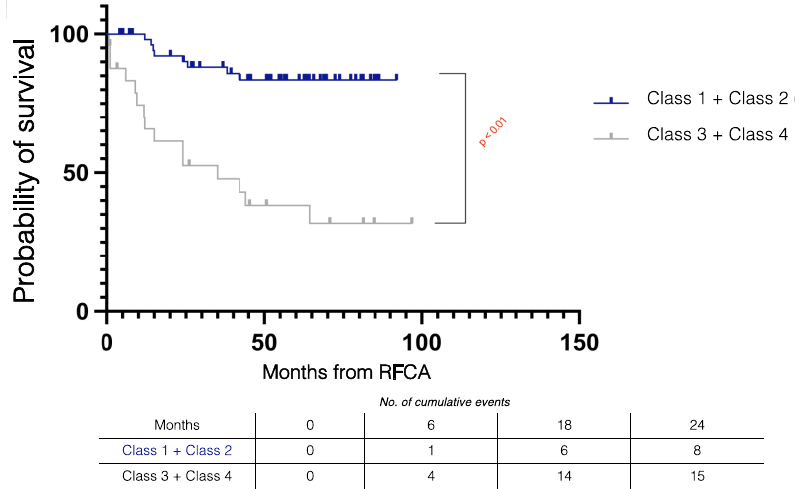
Figure 3. Kaplan–Meier survival curves stratified by combined procedural outcomes in electrical Figure 3. Kaplan – Meier survival curves stratified by combined procedural outcomes in electrical storm patients. RFCA = radiofrequency catheter storm patients. RFCA = radiofrequency catheter ablation.